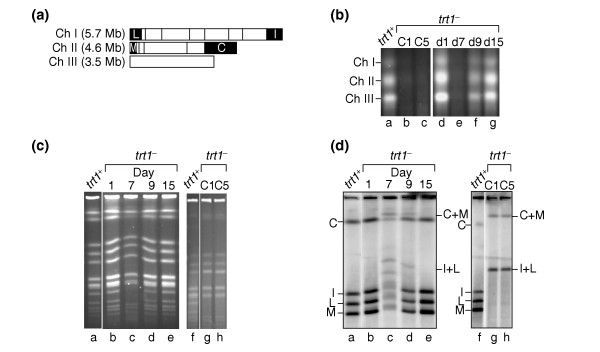
Chromosome structures of trt1- survivors. (a) The 13 NotI restriction sites in S. pombe chromosomes I and II [65] are indicated by vertical lines. Chromosome III does not have a NotI site. Terminal fragments are labeled according to convention and highlighted in black. (b) Pulsed-field gel analysis of intact chromosomes visualized by staining with ethidium bromide. Lanes d-g correspond to days 1, 7, 9 and 15 of the growth curve, respectively. (c) Pulsed-field gel of NotI-digested chromosomes visualized with ethidium bromide. Days 1,7, 9 and 15 correspond to days of the growth curve. Lanes a and f were repositioned from the original gel image. (d) The gels from (c) were transferred to a nylon membrane and probed with a mixture of 32P-labeled probes to internal regions of the C, I, L and M fragments, identified in (a). The terminal fragments of linear chromosomes are labeled on the left, and fragments C+M and I+L resulting from circularized chromosomes are shown on the right.